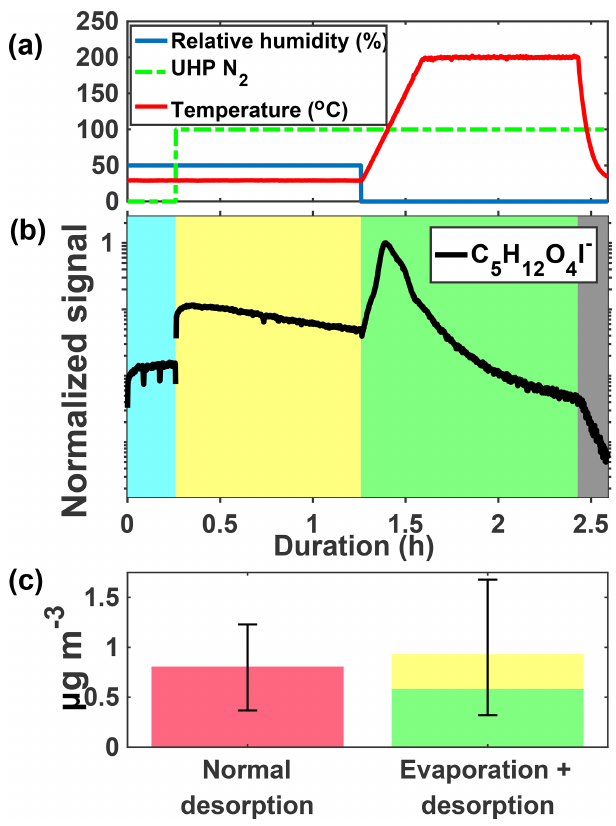
Figure 4. Schematic of the isothermal evaporation process. (a) Rel- ative humidity (blue), N 2 flow (green, 0: off, 100: on), and tem- perature (red). (b) C 5 H 12 O 4 I − during a 1h isothermal evapora- tion experiment shaded by the phase of the experiments: simulta- neous real-time gas-phase sampling and offline aerosol collection (blue), isothermal evaporation whereby compounds are measured as they evaporate off the filter (yellow), temperature-programmed ther- mal desorption (green), and cooldown of the heating tube (gray). (c) Mass concentration of C 5 H 12 O 4 measured during a normal des- orption (pink, left) versus the isothermal evaporation + desorption (yellow and green, right) for the same chamber